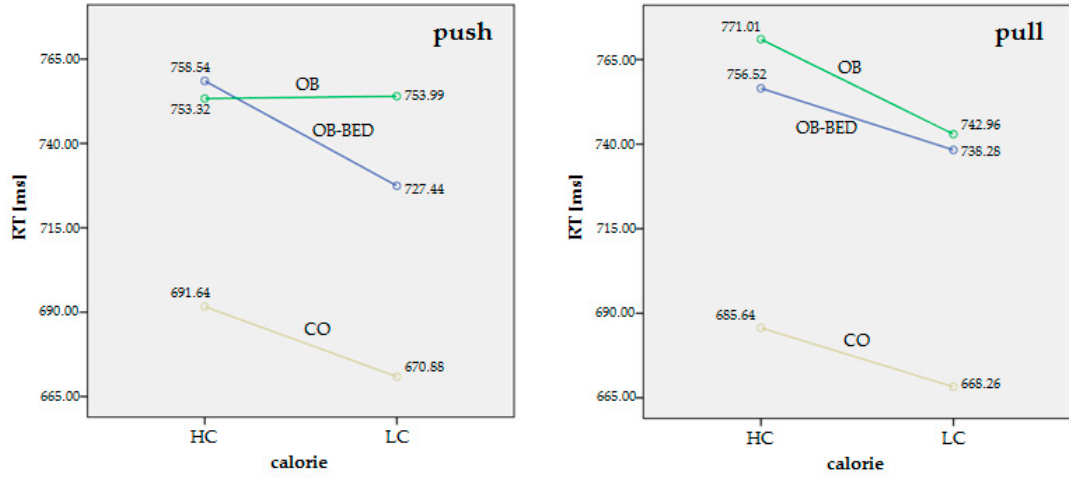
Figure 2. This figure shows the results of rm-ANOVA with two repeated measures factors (calorie: high-calorie (HC) vs. low-calorie (LC) food cue content and direction of motion: push vs. pull). As a main result, a three-fold interaction “group” × “calorie” × “direction” (OB-BED/OB/CO × HC/LC × push/pull) was found (F 2,70 = 4.02; p = 0.02). Within the groups, RTs may be interpreted as an avoidance bias for LC in the OB-BED group and an approach bias for LC in the OB group (for more details see main text). OB-BED = patients with obesity and current BED, OB = subjects with obesity without BED, CO = norm-weight controls without self-reported lifetime eating disorder diagnosis. HC = high-calorie food picture, LC = low-calorie food picture. RT = reaction time in milliseconds